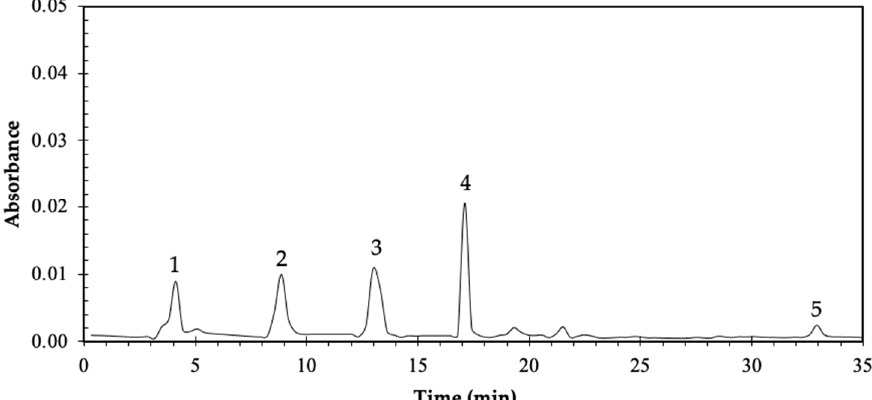
Figure 2. Typical HPLD-DAD chromatogram (shown at 320 nm) of methanolic extracts from carrot pomace obtained as a by-product after juice extraction, treated with UVC radiation for 30 min, and stored at 25 °C for 48 h. Peak identification: 1. protocatechuic acid; 2. gallic acid derivative; 3. 3,5-dicaffeoylquinic acid; 4. chlorogenic acid; 5. ferulic acid. Phenolic compounds were identified by comparing spectra characteristics of the chromatographic peaks with authentic chemical standards and previous reports [20,21].